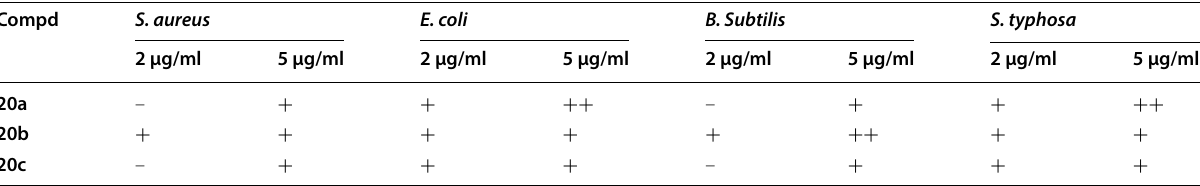
Inhibition zone diameter: (–) < 11 mm [inactive]; (